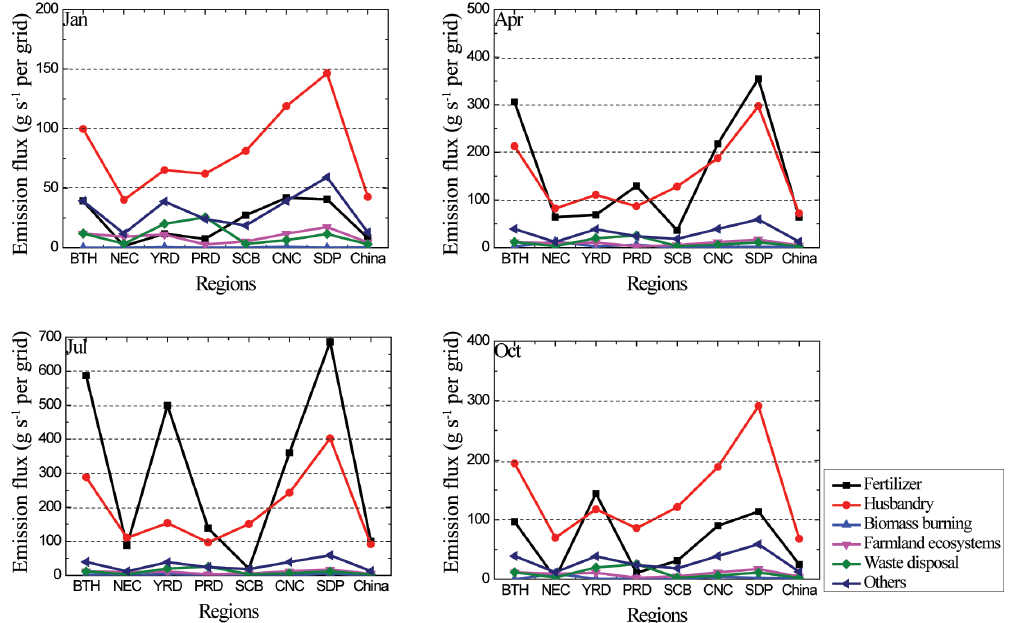
Figure A5. The regional average NH 3 emission flux (gs − 1 per grid) of different agriculture sectors over each region in January, April, July, and October.